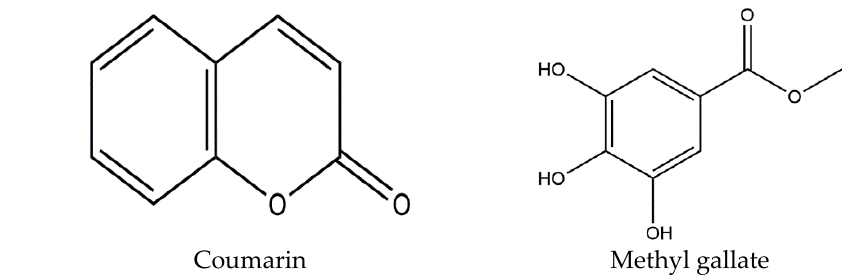
Figure 2. Diagrammatic representation of different chemical structures.